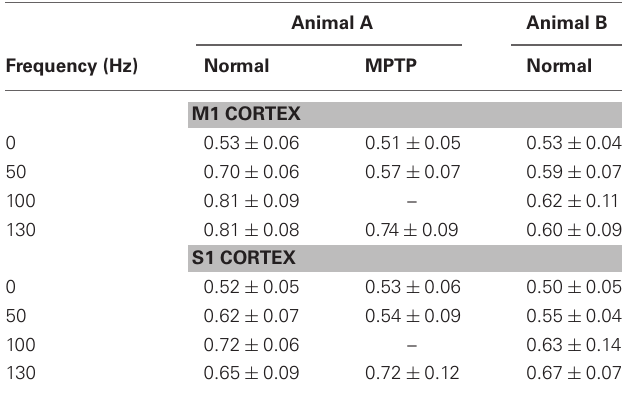
Table 2 | AUC values (mean ±